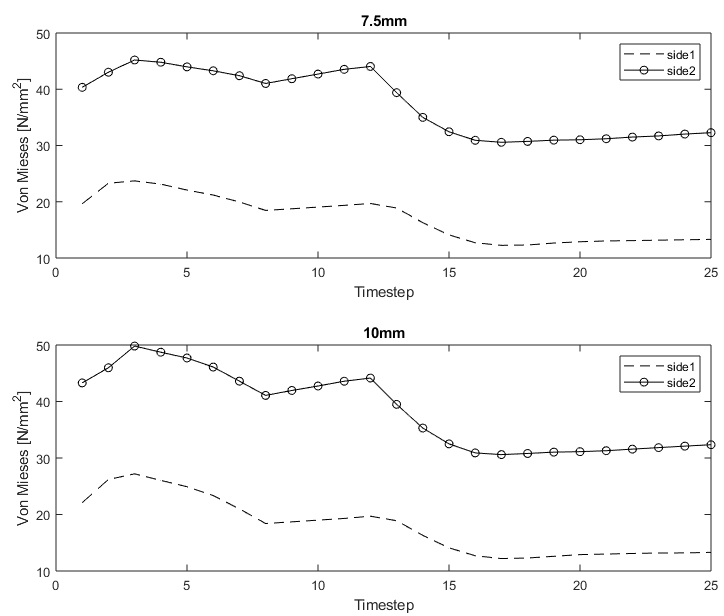
Figure 9. 7.5 mm pit comparison side 1 and 2 ( Top )—10 mm pit comparison side 1 and 2 ( Bottom ).